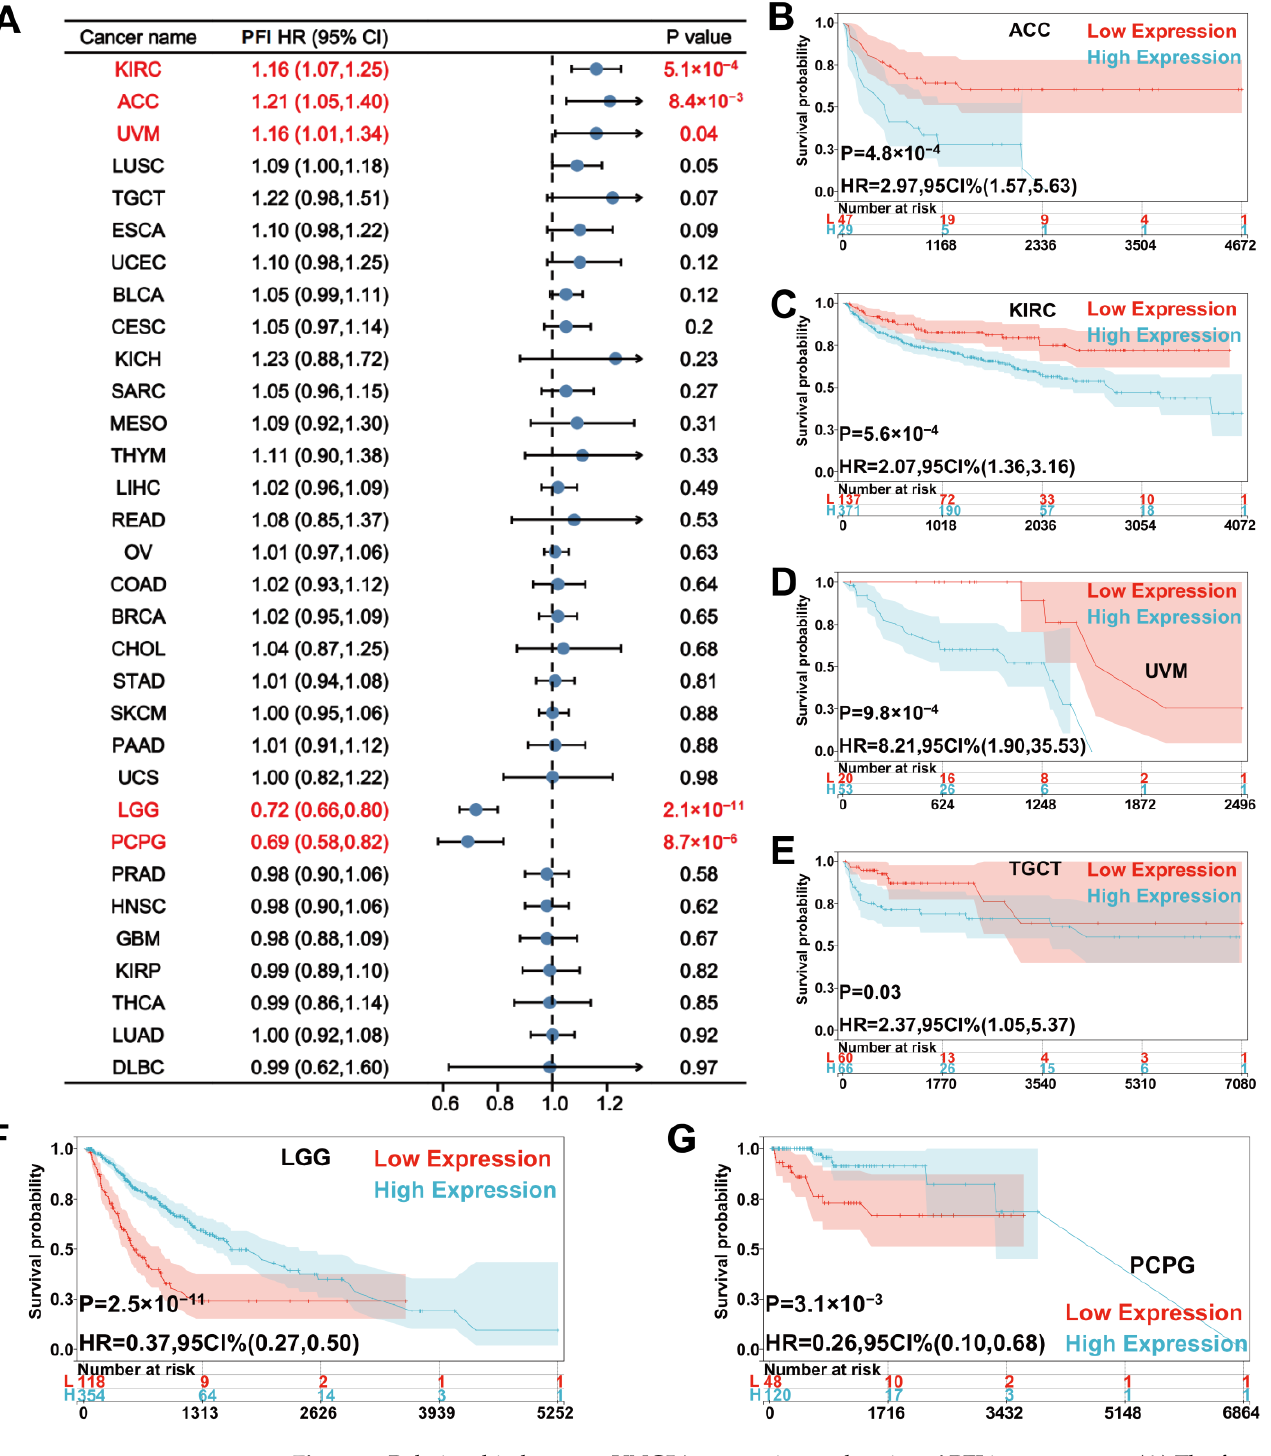
Figure 5. Relationship between UNC5A expression and patients’ PFI in pan-cancer. ( A ) The forest plot shows the relationship of UNC5A expression with PFI in pan-cancer. ( B – G ) Kaplan-Meier analysis shows the association between UNC5A expression and PFI in pan-cancer. Subsequently, time-dependent ROC curves were plotted to examine the prognostic value of UNC5A expression in the prediction of 1-, 3-, and 5-year survival in terms of DSS, OS, and PFI in pan-cancer. UNC5A is a candidate prognostic biomarker for multiple can- cer types. For example, the AUC values for predicting the corresponding 1-, 3-, and 5-year